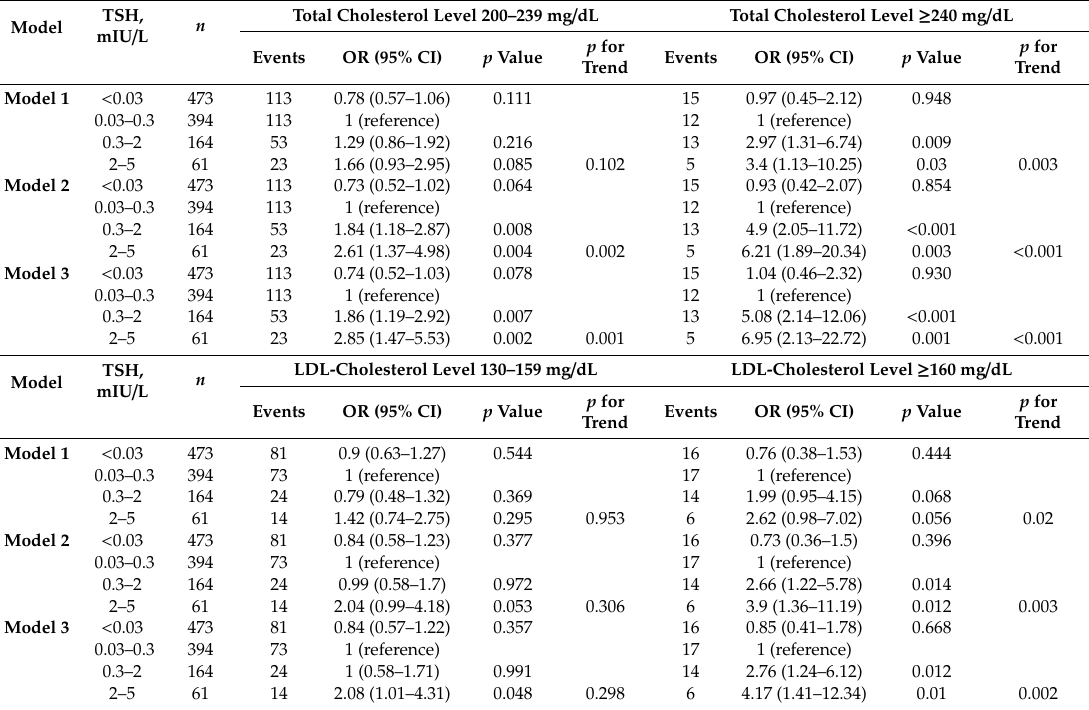
Table 3. Association between follow-up TSH level and